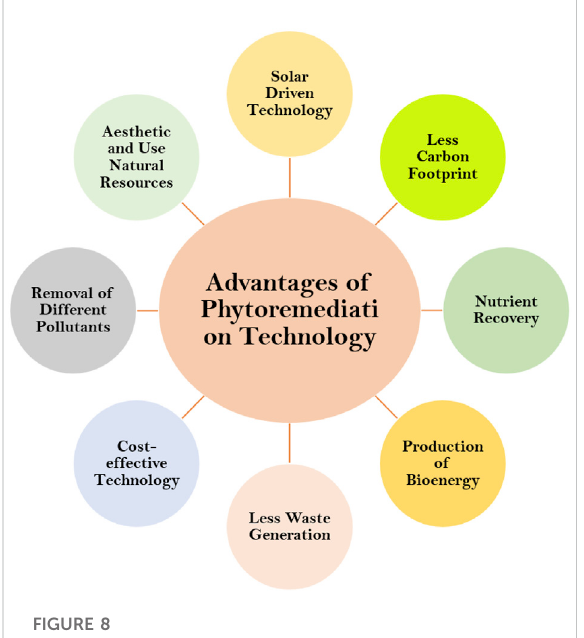
FIGURE 8 Advantages of phytoremediation technology.